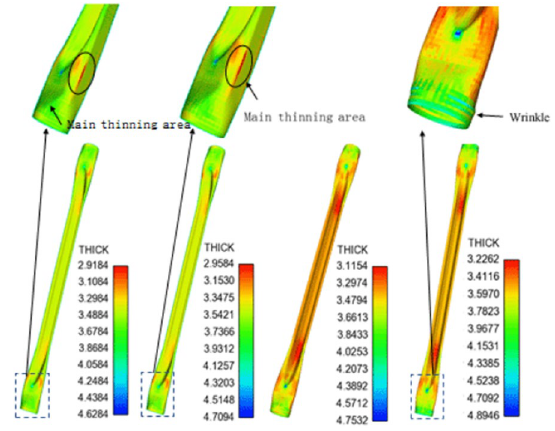
Figure 41 Cloud maps of the distribution distribution of the wall thicknesses of torsion